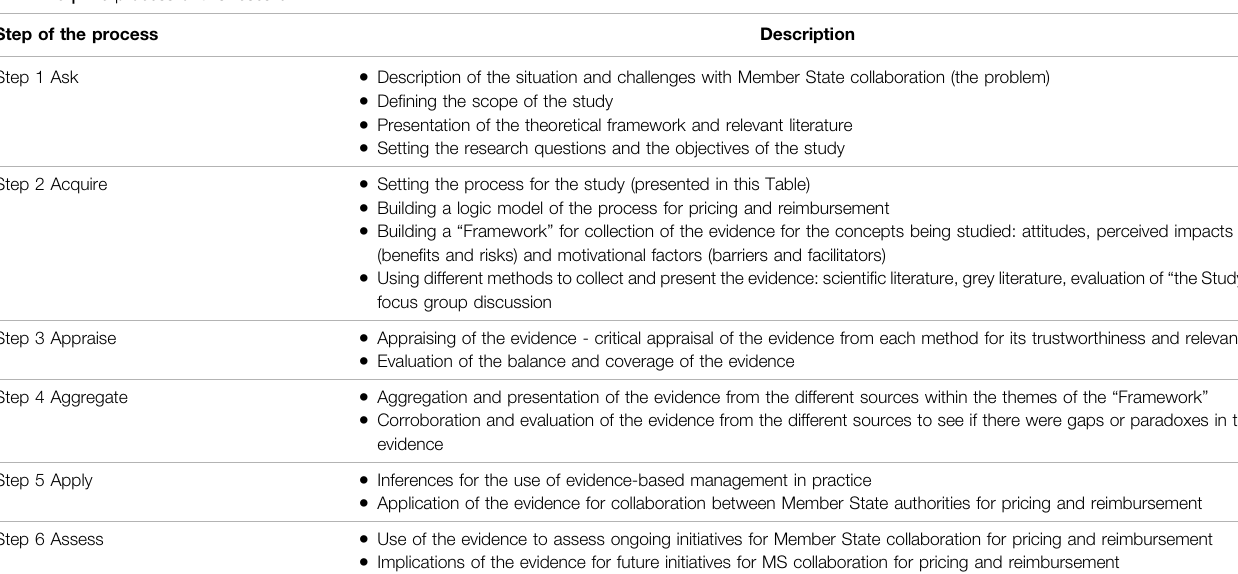
TABLE 3 | The process of this